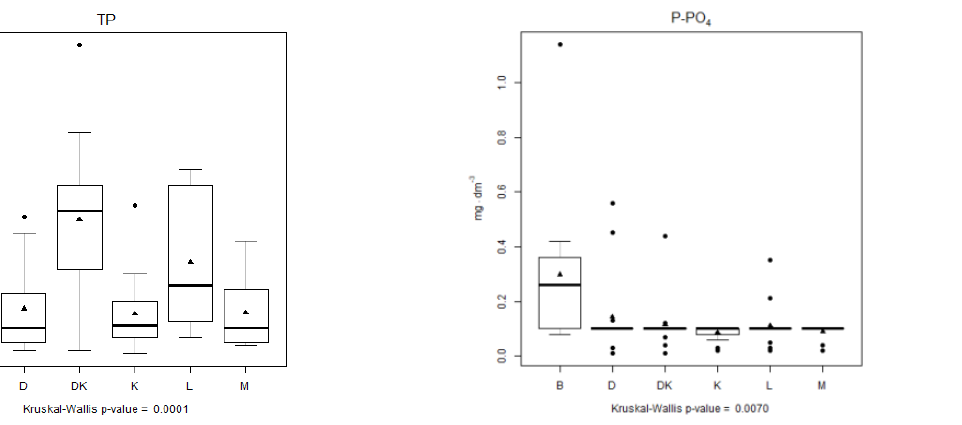
Figure 5. Distribution of the values of the investigated physical–chemical parameters of piezometric groundwater at the study sites in the years 2011–2014. The box-and-whisker plots show the distribution of the observations. In particular, the box represents the first and third quartiles. The horizontal line across the central region of the box represents the median. The mean value of the data is marked by a red filled triangle. The whiskers are drawn to the most extreme observations located no more than 1.5 times the inter-quartile range away from the box. Any observation not included between the whiskers is considered as an outlier and is plotted with a filled circle. When there are no outliers, the whiskers indicate the minimum and maximum values. The plot presents observed values of particular parameters, marked with blue dots.